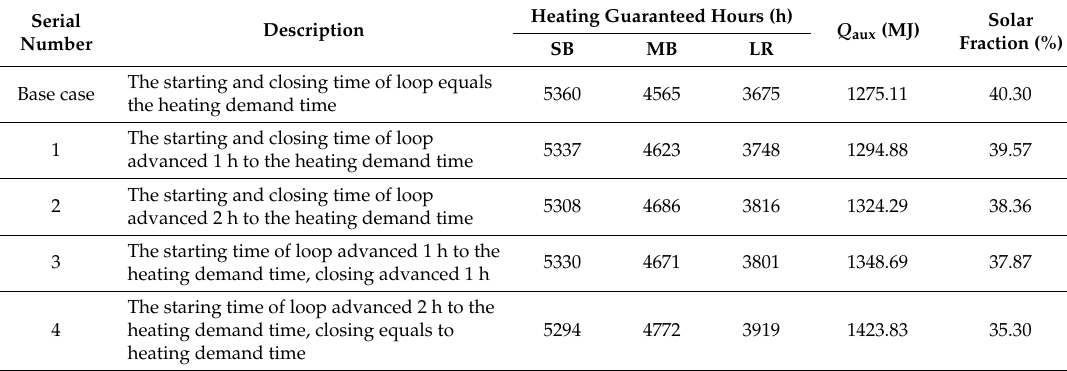
Table 7. Heating effect and system performance evaluation of on–off operation time of